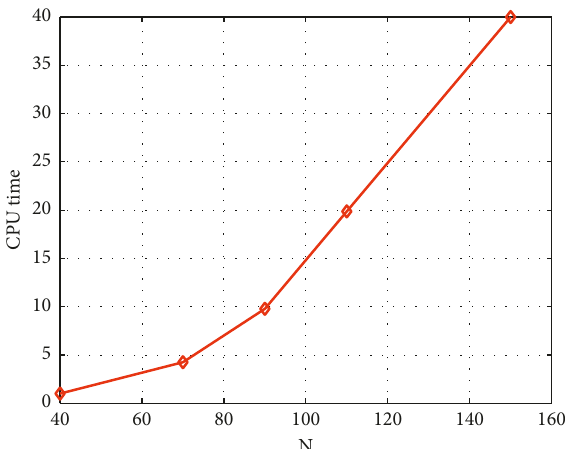
Figure 9: CPU times for Example 2 with different values of N